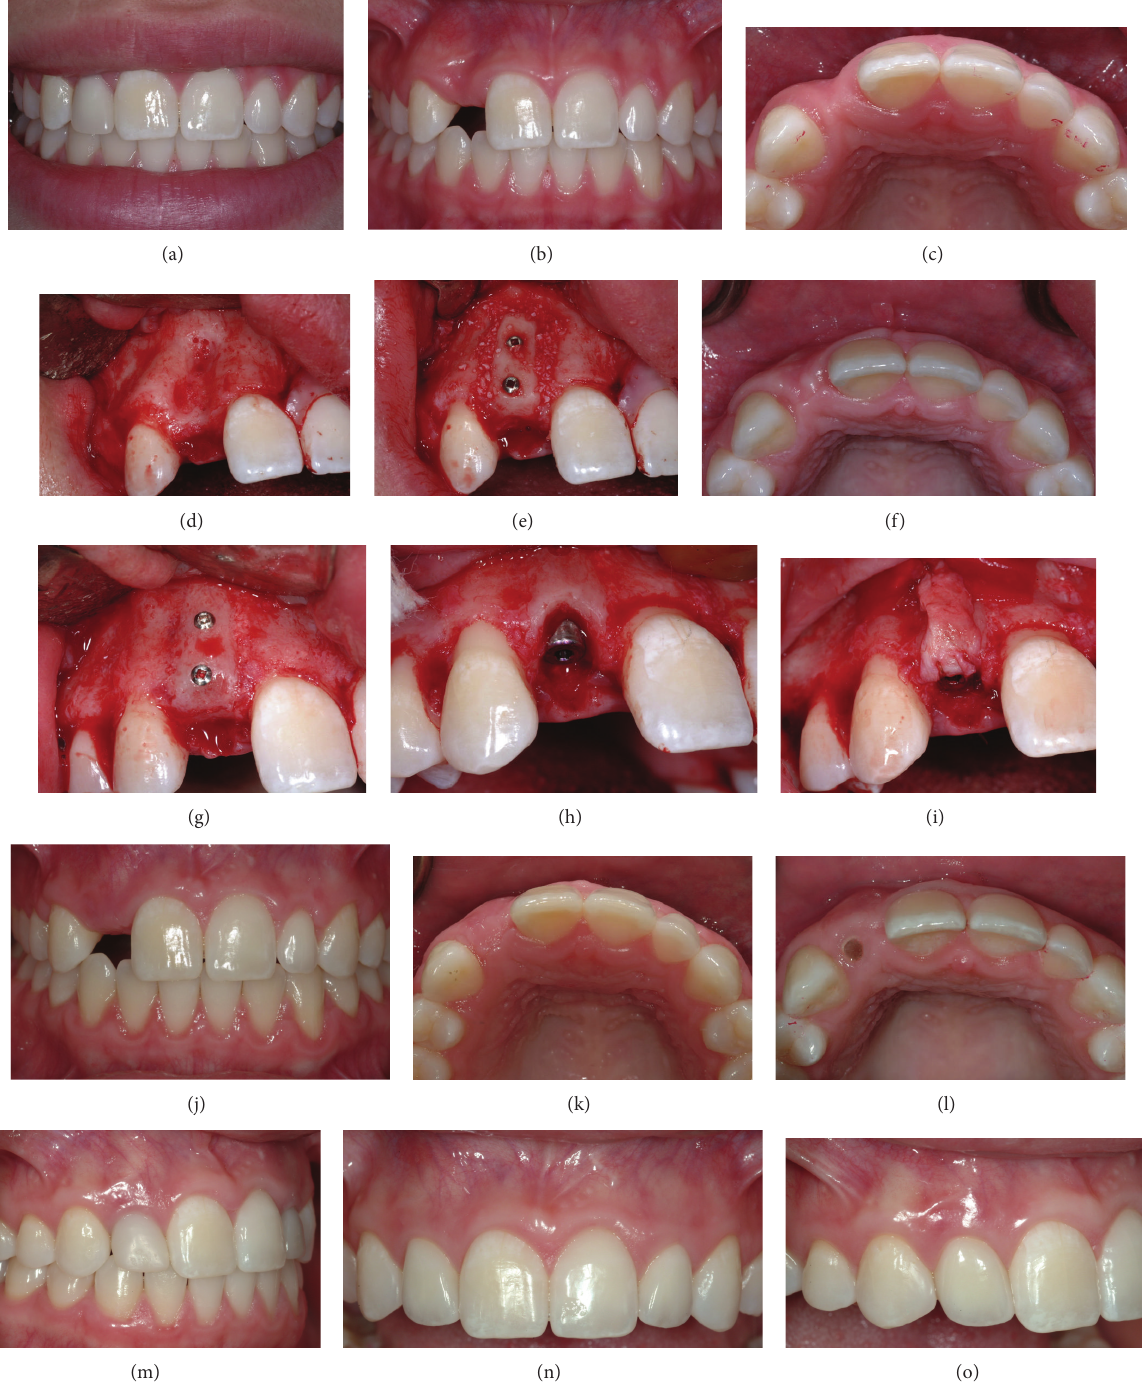
Figure 3: ((a), (b), and (c)) Patient presented for implant rehabilitation of number 7 lateral incisor. Not the high interdental smile line that poses an esthetic challenge. Following ridge resorption, a concavity consistent with a Seibert Class I defect is seen in the edentulous site. ((d), (e),and(f))Ablockautograftwasscrewedinplacetoachievehorizontalridgeaugmentationpriortoimplantplacement.Particulatedallograft was utilized to graft the area between the block and the recipient bed. Note the significant enhancement of the tissue profile postsurgically. ((g), (h), and (i)) At four months after grafting the site was reentered and an implant was placed in the ideal 3-dimensional position. A SCTG was utilized to replicate the root eminence and provide a natural emergence profile. ((j), (k), (l), and (m)) Postoperative healing view shows excellent tissue contours at the site. A customized healing abutment was selected to mold the tissues after 2nd stage surgery. Note the excellent positioning of the mucosal zenith at the time of provisionalization. ((n), (o)) Intraoral view of the final restorations in place. Crown lengthening was performed on the adjacent teeth to address the patient’s overall esthetic demands. Note the excellent replication of gingival characteristics on the peri-implant mucosa and the natural appearance of the restoration as it emerges from the augmented hard on soft tissues at the